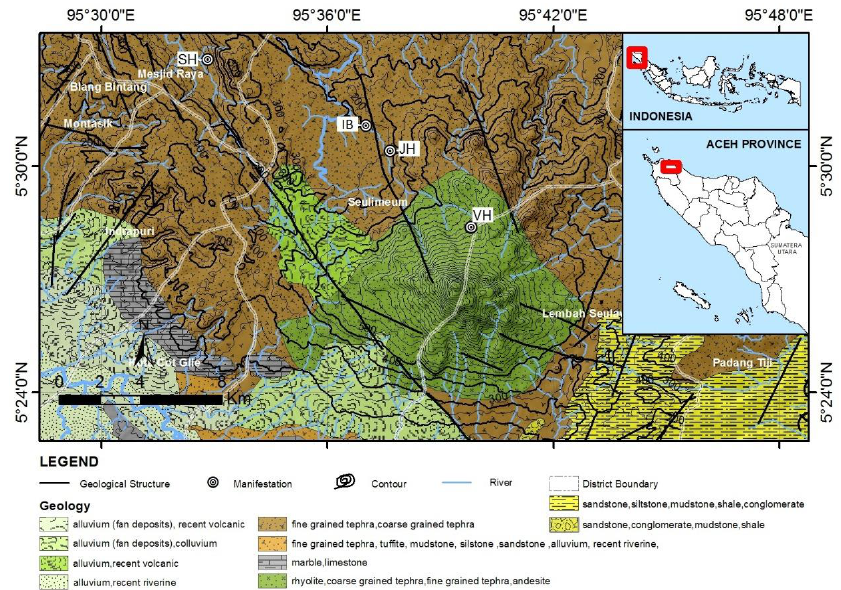
Figure 1. Geological Map of Seulawah Agam Mountain, Aceh Besar district, Indonesia. Sampling point codes; SH ( Ie- Seu’um ); IB ( Ie-Brôuk ); JH ( Ie-Jue ); VH (Van-Heutz crater).